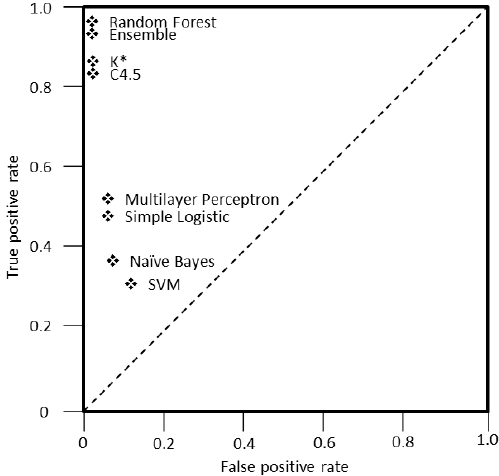
Figure 10. Classifiers receiver operating characteristic (ROC) space graph.